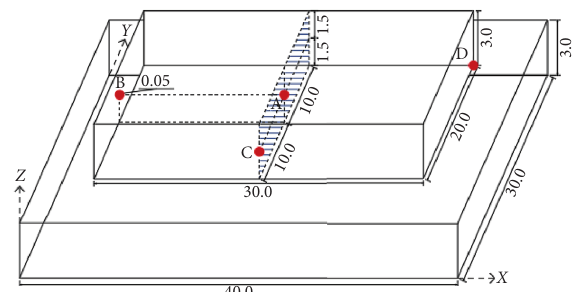
Figure 1: Main size and research points of the concrete foundation.